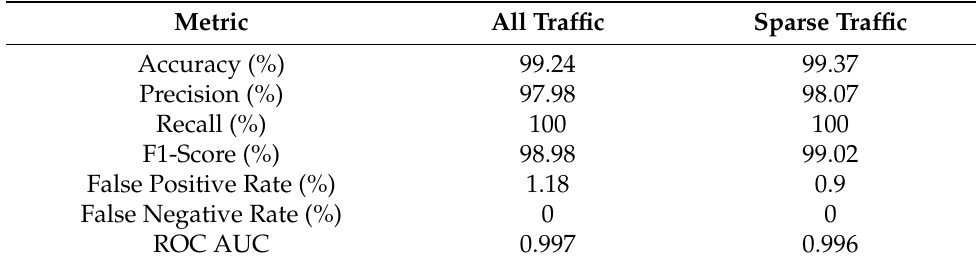
Table 2. LSTM Autoencoder flow detection results.